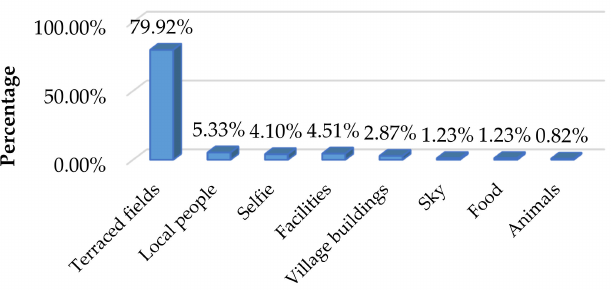
Figure 5. Themes of tourist photos in tourists’ comments about Honghe on Mafengwo.cn (2018–2019). For tourists, the terraces are the center of the tourism imaginary of the landscape, and the place is imagined as a stereotyped overlooking scene of terraces, a schema, separated and independent from other components of the Hani landscape. Table 2 shows patterns of image formations in tourist photos related to terraced fields. We identified seven image compositions. Among the photos, more than half used the entire picture to show the layered pattern of the terraces (32.31%) or the panorama taken from the viewing deck (23.08%) (Figure 6a,b). “Sunrise” (14.87%), “terraced fields amid fog/sea of clouds” (11.28%), “sunset” (10.26%), and “blue terraces” (4.62%) were also frequently used patterns by tourists who took photos of terraced fields (Figure 6c–f). Table 2. Image formation analysis on “terraced field” photos in tourists’ comments about Honghe on Mafengwo.cn (2018–2019).